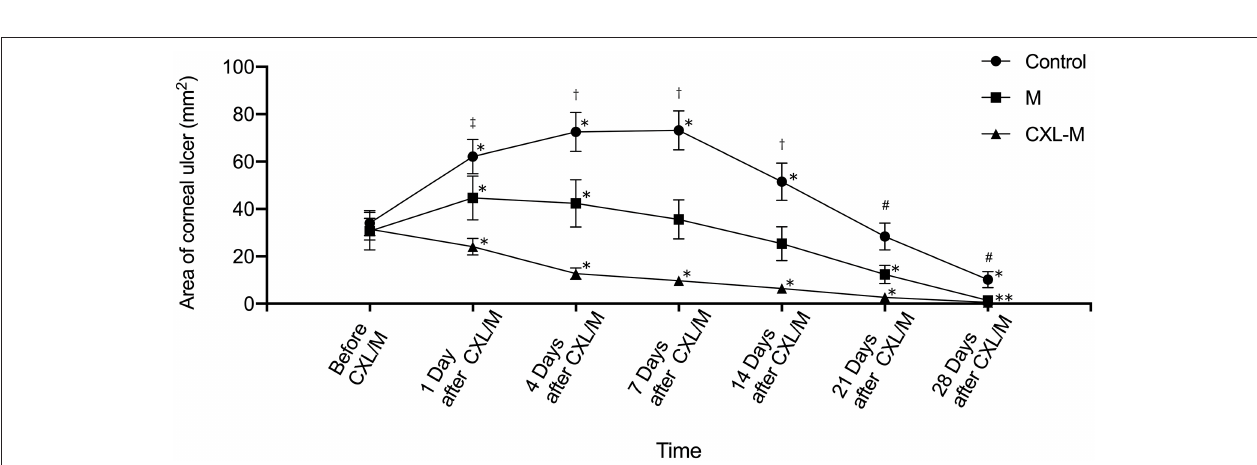
FIGURE 2 | Histopathology of corneas in each group 72h after corneal stroma injection. The corneal tissue of rabbit in each group was subject to HE staining. (A,D) , control group; (B,E) , M group; (C,F) , CXL-M group. (D–F) (X40) are the magnification of the content of the boxes in (A–C) (X20), respectively; and the white arrow refers to the fungal